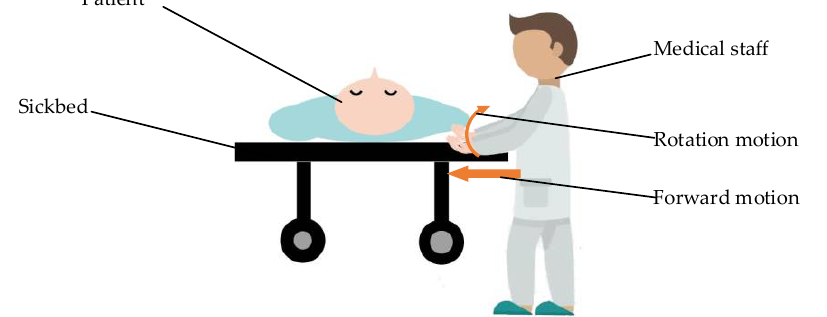
Figure 1. Clinical transfer process of patients.